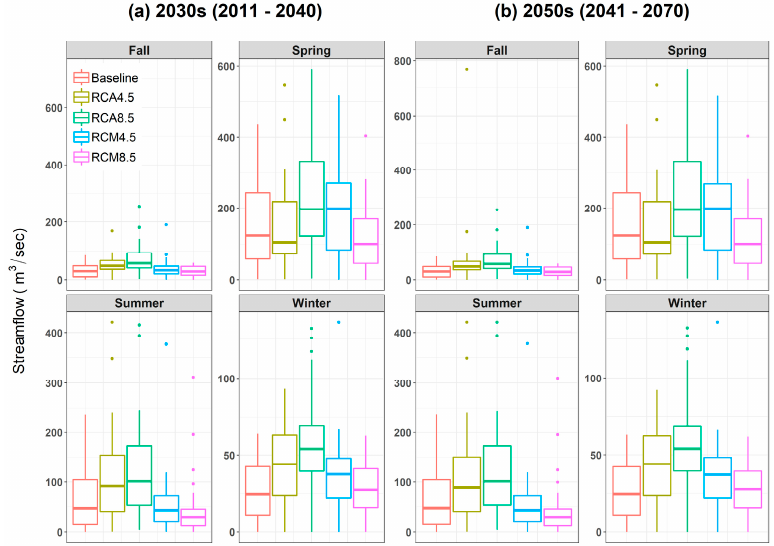
Figure 8. Seasonal streamflow boxplot for ( a ) 2030s (2011–2040) and ( b ) 2050s (2041–2070) under RCP4.5 and RCP8.5 for all climate change scenarios at the reservoir inflow point (HFC-MI gauge: 05MB999) along with the baseline simulation (1988–2017).